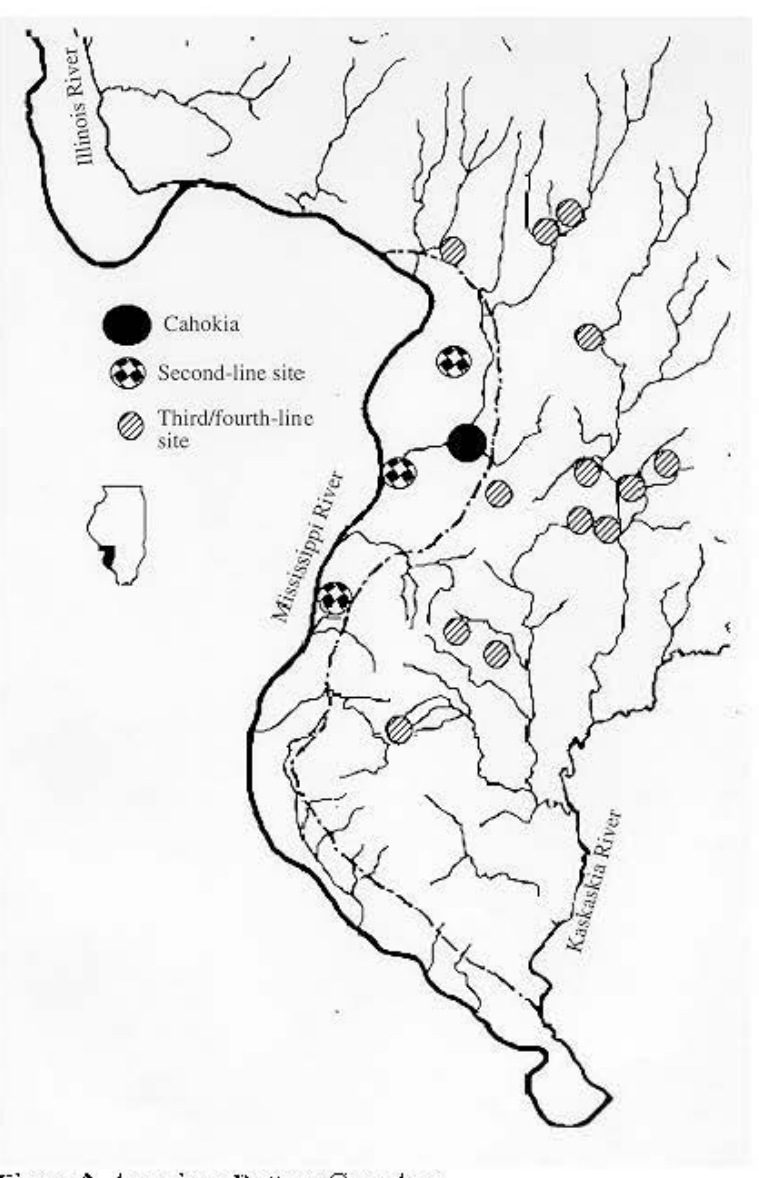
figure 1. American Bottom Core